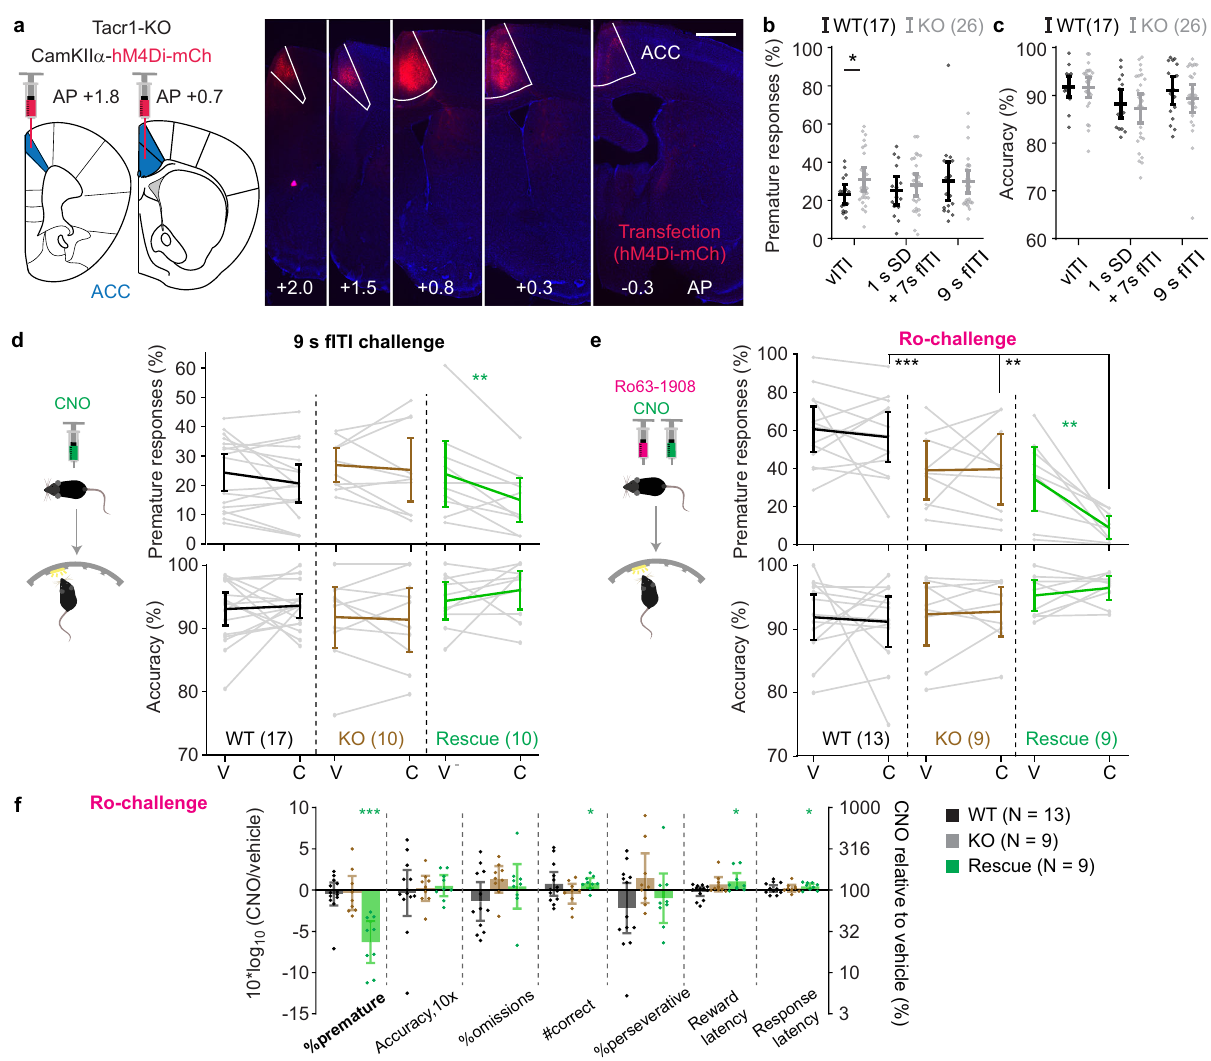
Fig. 7 Activation of the G i -cascade in pyramidal cells of the ACC reduces premature responding in a pharmacological model of impulsivity. a Transfection of the ACC with a CamKII α -hM4Di-mCherry vector (red) shown in different slices along the AP-axis (as indicated); scale bar, 1 mm. b Premature responding and c attentional accuracy in Tacr1 -knockouts (KO, grey) and littermate wildtype controls (WT, black) in impulsivity-promoting challenges, as indicated: variable ITI (vITI), combined reduction of stimulus duration (1 s) and fi xed-duration increase of ITI (7 s), and fi xed ITI increase (9 s fITI). Note that only 15 WT participated in the vITI and combined challenge, only 25 KO participated in vITI and 9s-fITI challenge. d , e Premature responding and accuracy after injection of vehicle (V) or CNO (C) ( d ), and double-injections of Ro/Veh (V) or Ro/CNO (C) as indicated ( f ) during the vITI protocol in KO (brown), WT (black), or KO with hM4Di-transfection in the ACC (Rescue, green). Coloured asterisks indicate signi fi cant paired post-hoc comparisons (Sidak) within the indicated group; black asterisks on horizontal lines indicate signi fi cant within-drug difference between rescue and control groups (Sidak). Note that in e , premature responses, there is also a signi fi cant drug-group interaction and effect of group in overall RM-ANOVA, and a signi fi cantly lower impulsivity in both KO groups compared to WT under Ro/vehicle condition (Sidak), not indicated. f CNO-induced changes in the 5- CSRTT Ro-challenge measured as log 10 -transform of the within-subject ratio (value after CNO/value after vehicle) for relevant behavioural performance parameters on the 5-CSRTT are shown for the three groups as indicated in the legend; asterisks indicate one-sample t -test against 0. See Supplementary Tables 3, and 15, 16 for reasons for varying N -numbers across experiments, statistics, and absolute numbers of responses. N -numbers stated in each panel. Doses of 10 mg/kg CNO were used throughout. * P < 0.05; ** P < 0.01; *** P ≤ 0.001; error bars, C.I.; individual dots or dot-lines represent